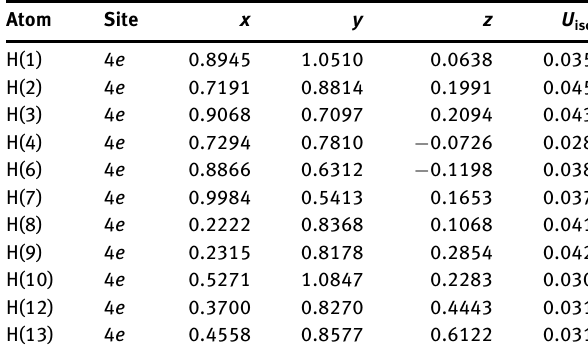
Table 2: Fractional atomic coordinates and isotropic or equivalent isotropic displacement parameters (Å 2 ).